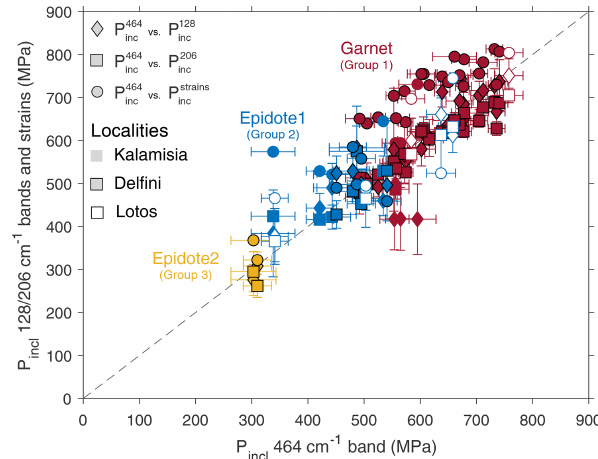
Figure 5. Comparison of P inc determined from different quartz bands using hydrostatic calibrations and by using phonon-mode Grüneisen tensors (strains). Red, blue, and yellow symbols indicate qtz-in-grt (Group 1), qtz-in-ep1 (Group 2), and qtz-in-ep2 (Group 3) results, respectively. Diamonds, squares, and circles indicate P 464 inc vs. P 128 , P 464 vs. P 206 , and P 464 vs. P strains results, respectively. No inc inc inc inc inc border, filled, and open symbols indicate analyses from Kalamisia, Delfini, and Lotos samples,